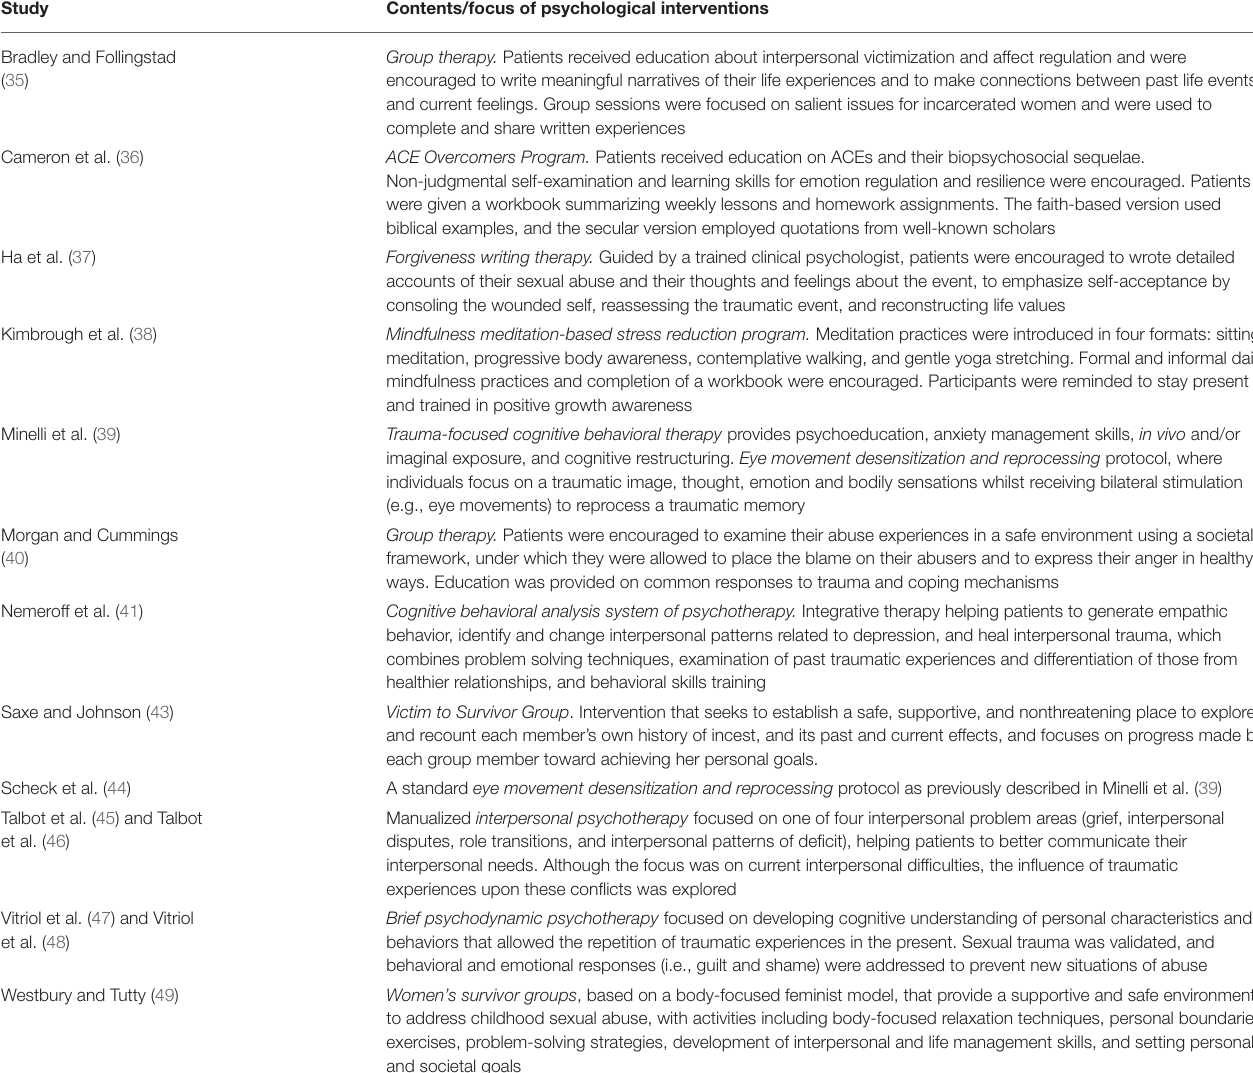
TABLE 2 | Synthesis of content of psychological interventions included.